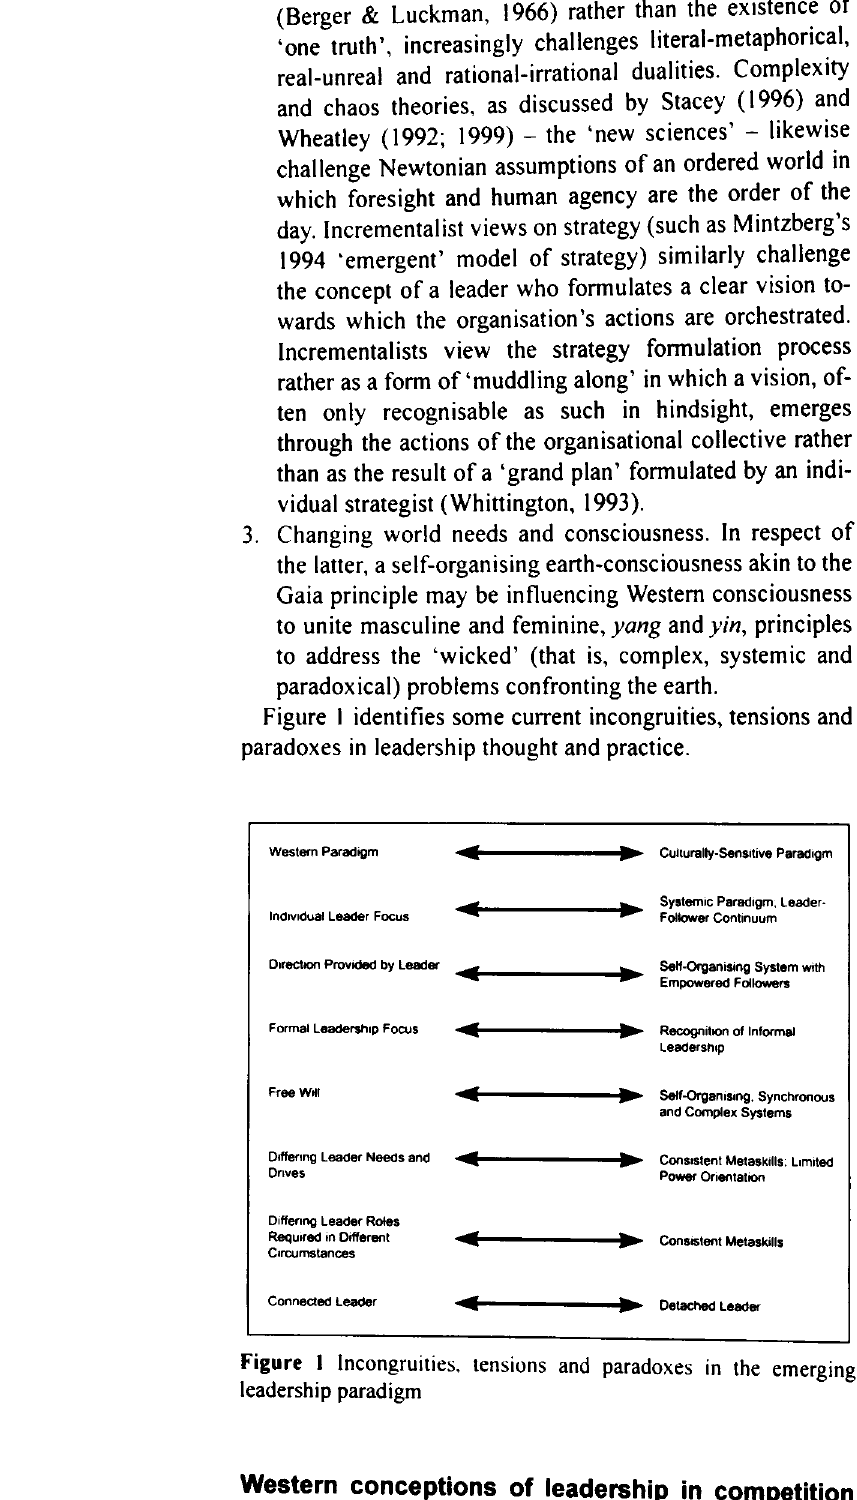
Figure I Incongruities. tensions and paradoxes in the emerging leadership paradigm